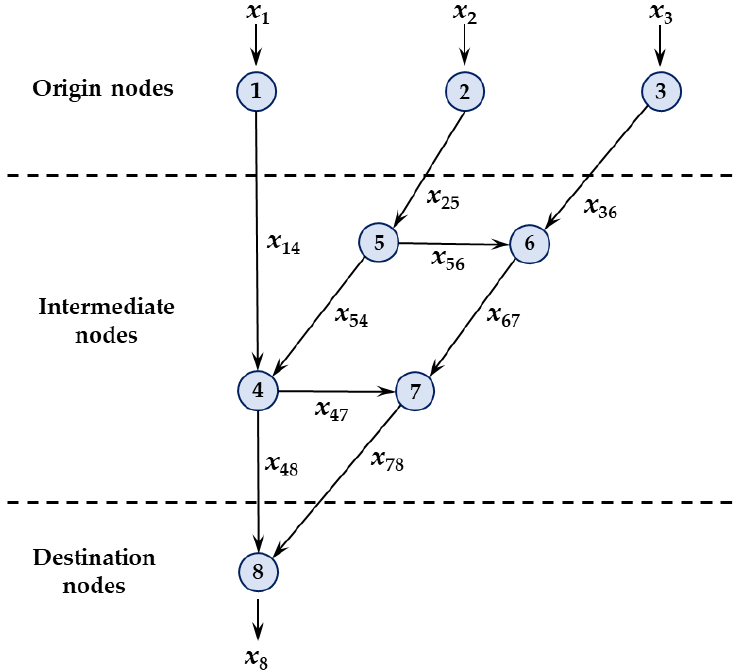
flows along nine transport links. Traffic flow marked as x 8 , which is the sum of flows in all origin nodes, is headed for the destination node.